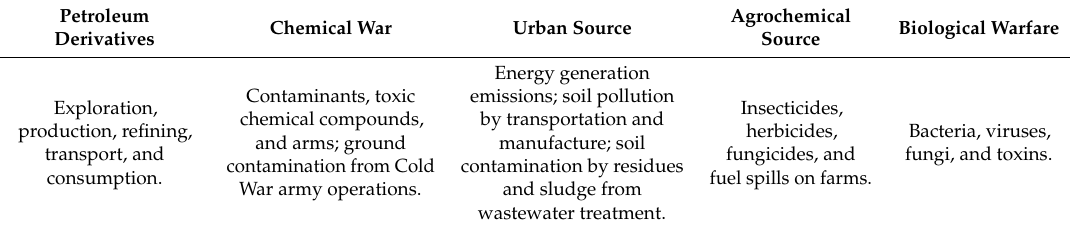
Table 1. Main sources of soil contamination.